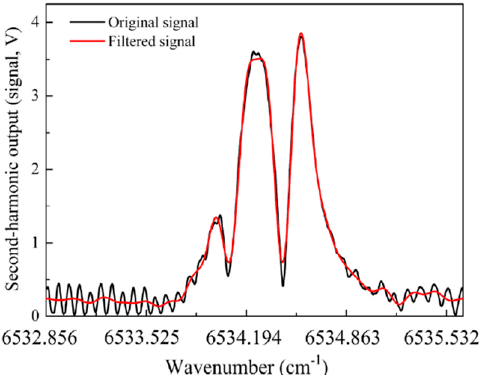
Figure 10. WMS signal (second harmonic) presented in [48]. Optical fringes (visible in the background of the original signal) could be removed in post-processing. Reprinted with permission from [48], © The Optical Society.